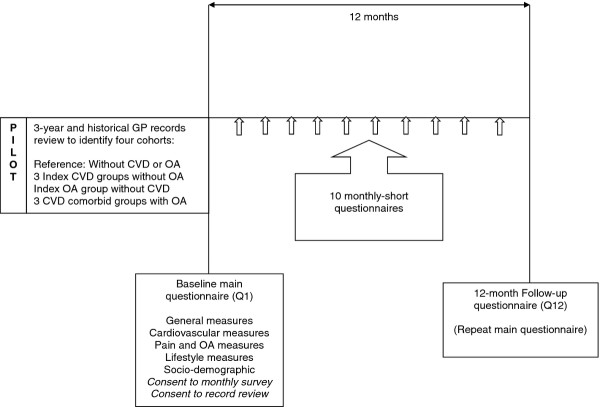
2C study design.